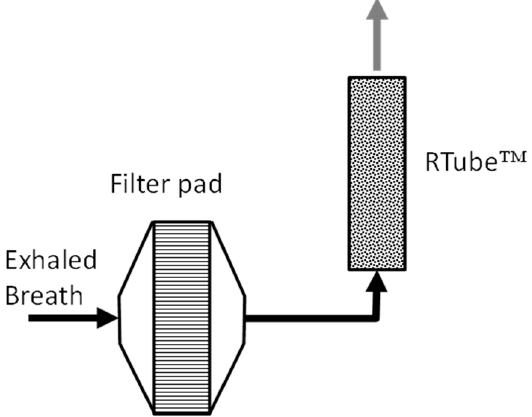
Figure 3. Exhaled breath condensate collection system (EBS) diagram.